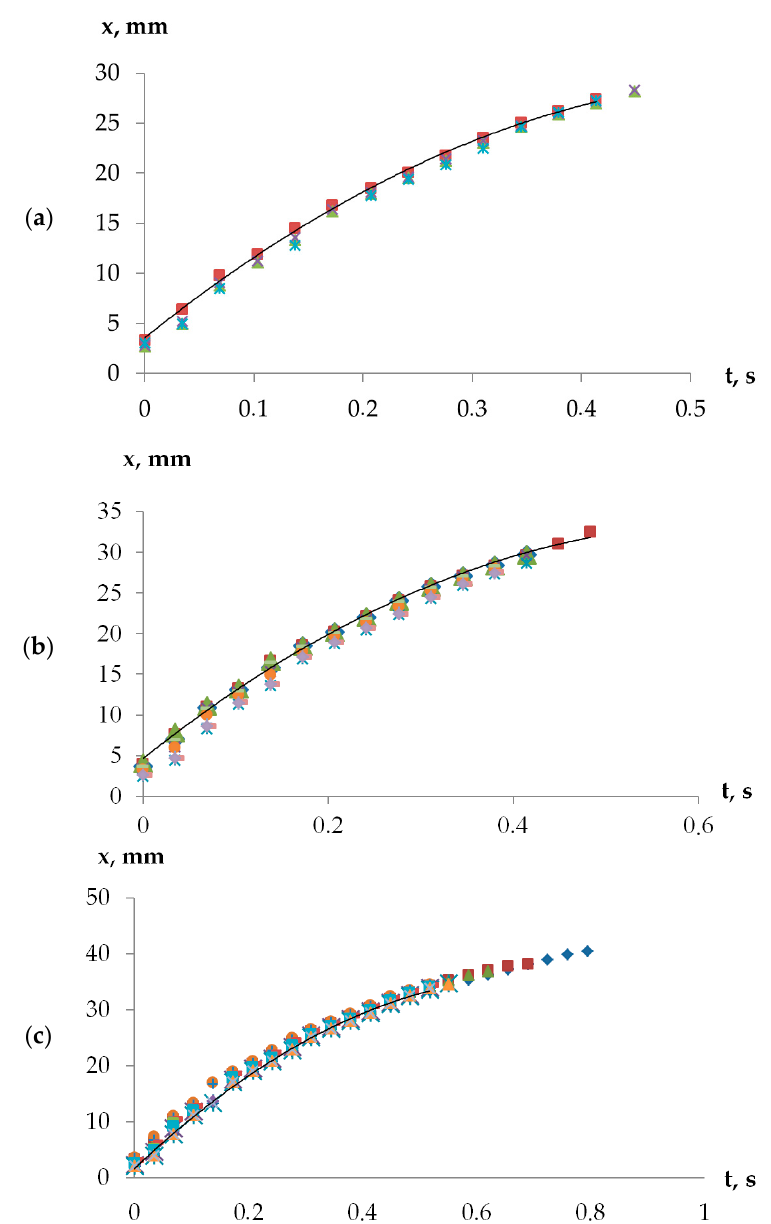
Figure 4. Plots of the dependence of the coordinates of the movement of the droplet on time: ( a ) at 0A; ( b ) at 0.9A; ( c ) at 1.8A. Table 6. Acceleration, velocity, and cross-sectional area of water droplet movement in the channel at different values of the current applied to the